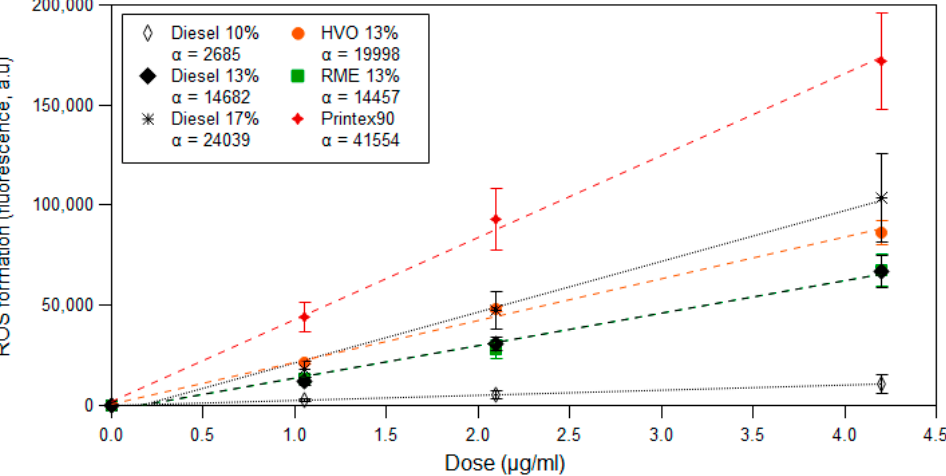
Figure 5. The dose response reactive oxygen species (ROS) generation of the samples with error bars of ± 1 standard error of the mean. Only the lowest doses are displayed to show the linear dose-response relationship. The slope of these lines is used as a measure of the ROS formation potential per mass unit ( α ) of each material. The ROS curves reach a plateau (not shown) at higher doses due to depletion of reactant (2 ′ ,7 ′ -dichlorodihydrofluorescein diacetate (DCFH 2 -DA) probe), hence the slope of the linear regression is based on the first data points where linearity is observed.